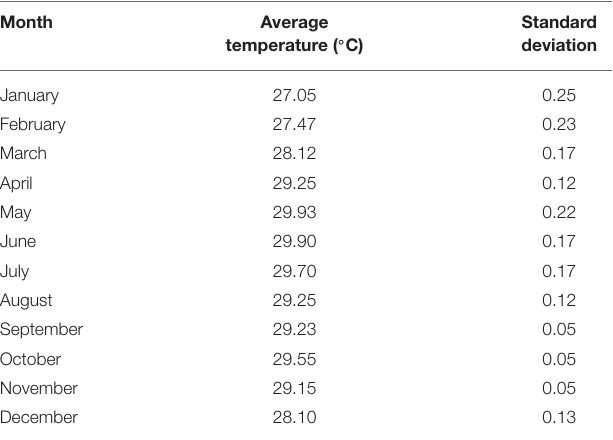
TABLE 3 | Seawater temperature on the east coast of Peninsular Malaysia